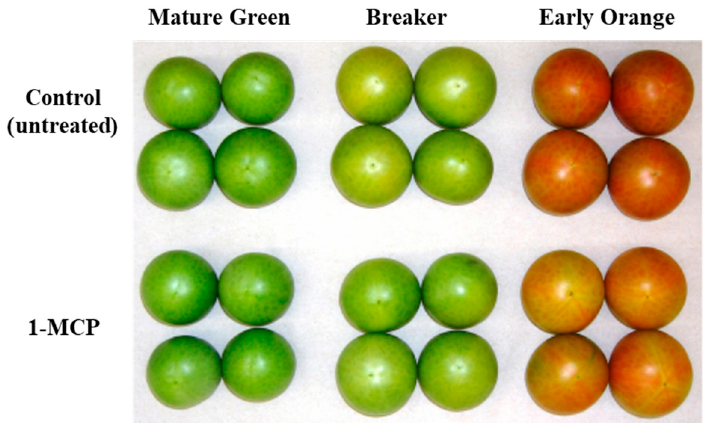
Figure 1. Tomatoes harvested at different ripening stages and treated with 1-MCP (untreated fruit served as control), after 24 h at 20 °C, the time of sampling for molecular analysis.